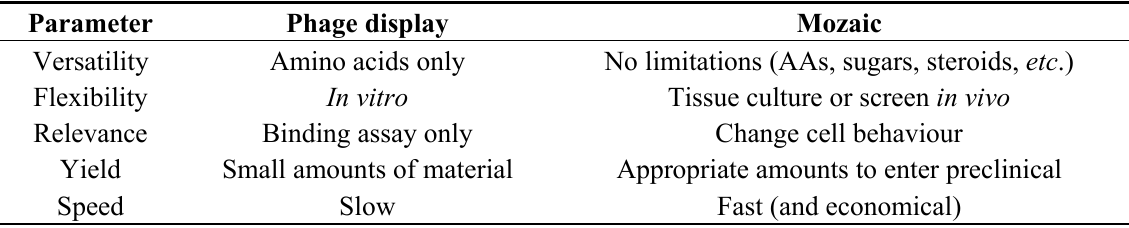
Table 1. Comparision of Mozaic and phage